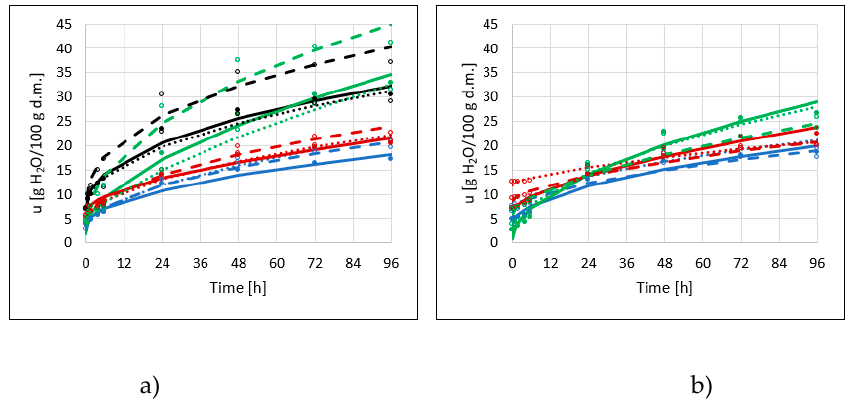
Figure 4. Water adsorption kinetics of dried apples obtained by different drying methods (CD—solid lines, VM—dashed line, CD / VM— dotted line), previously osmo-dehydrated in erythritol (blue lines), xylitol (green lines), sucrose (red lines), and without OD (black lines), without application of ultrasound ( a ) or with US pre-treatment ( b ).